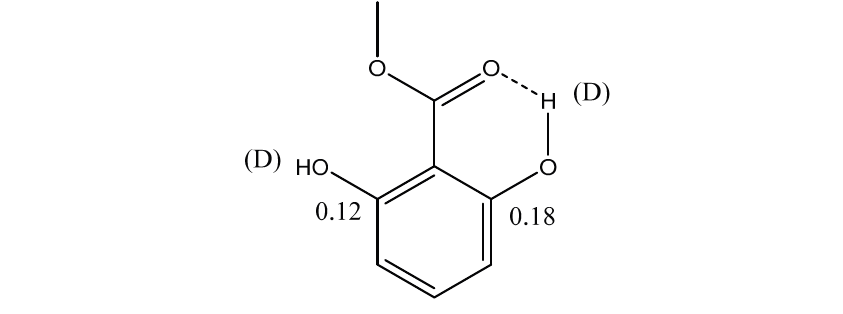
Figure 5. Isotope effects (in ppm) in methyl 2,6-dihydroxybenzoate. Data from Ref. [21].